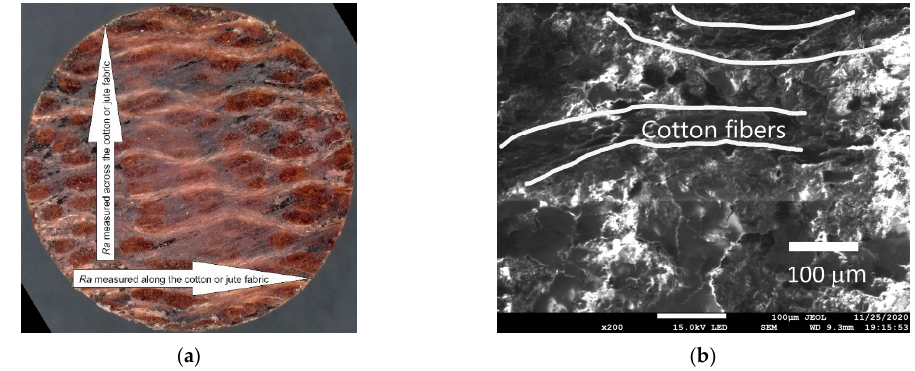
Figure 19. ( a ) Direction of roughness (Ra) measurements on the surface of the polymeric composites pin and ( b ) SEM micrograph of the PF+cotton+MoS 2 pin.